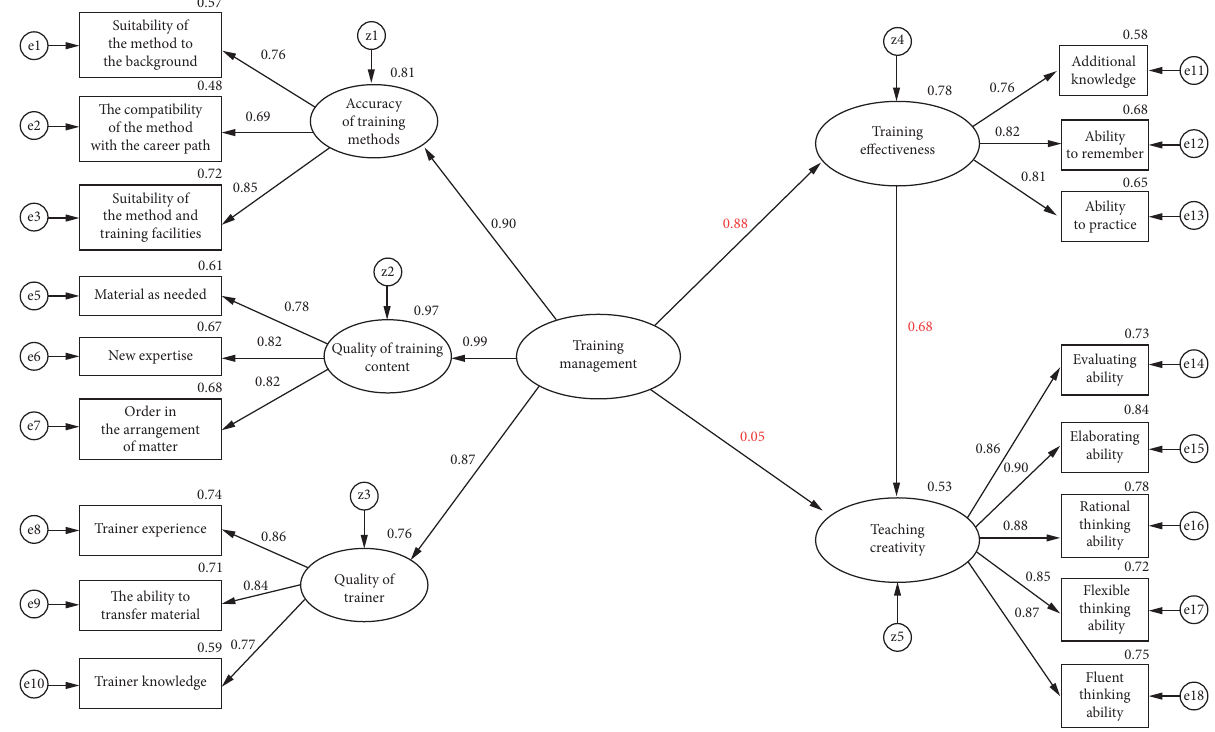
F IGURE 2: Direct and indirect effect